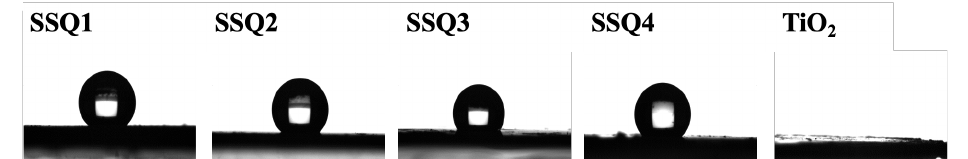
Figure 8. Images of water droplets during sessile drop analysis of TiO 2 +SSQ1, TiO 2 +SSQ2,